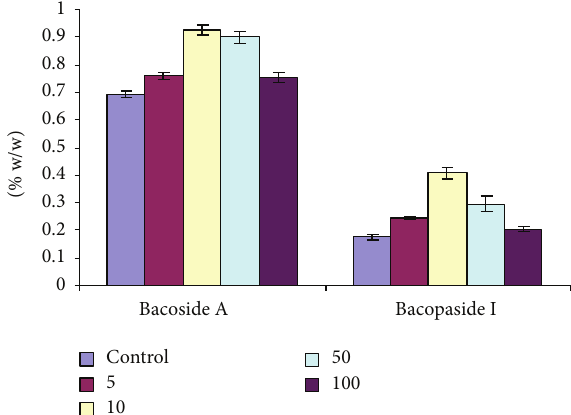
Figure 2: Effect of cadmium on the bacoside A and bacopaside I content in B. monnieri